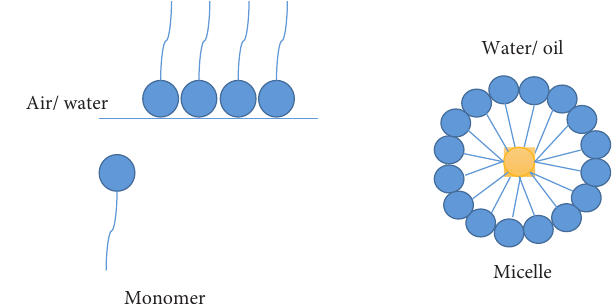
Figure 1: Interfacial and surface tension of the surfactant monomer (polar head and hydrocarbon tail); micelle formation in water/oil.